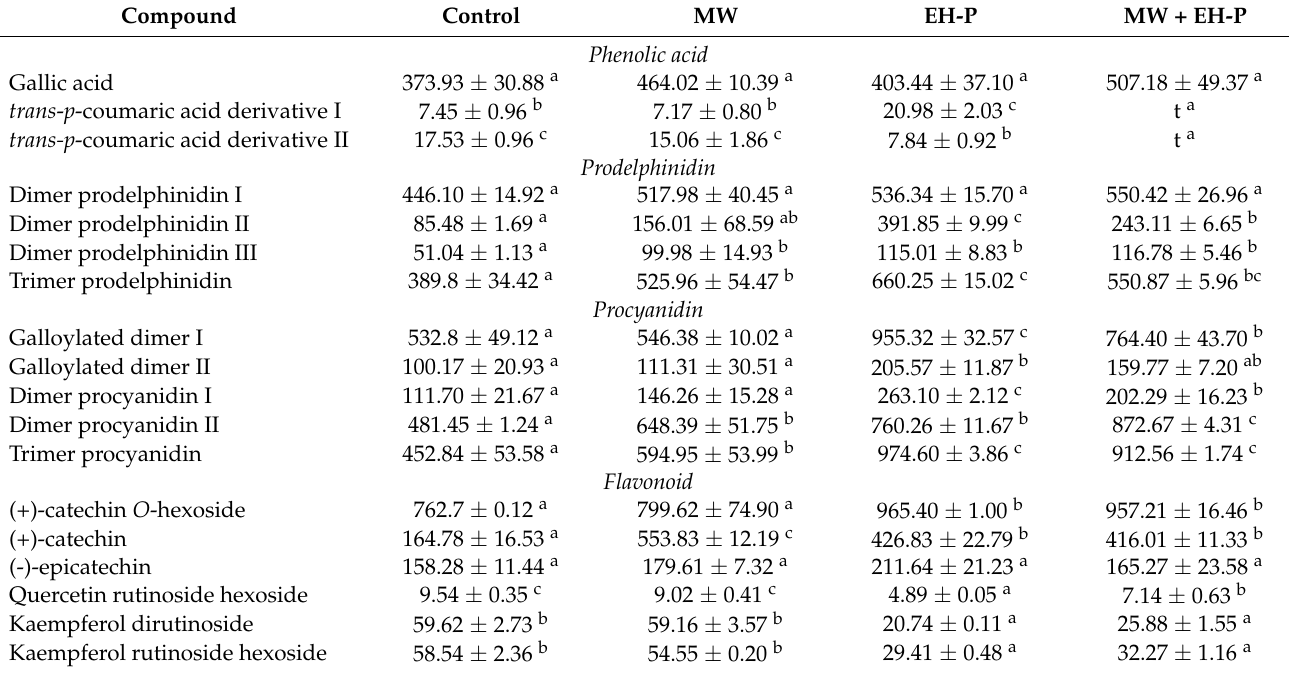
Table 4. Effect of MW, EH-P and MW + EH-P on individual phenolic compounds ( µ g/g DW) of lentil